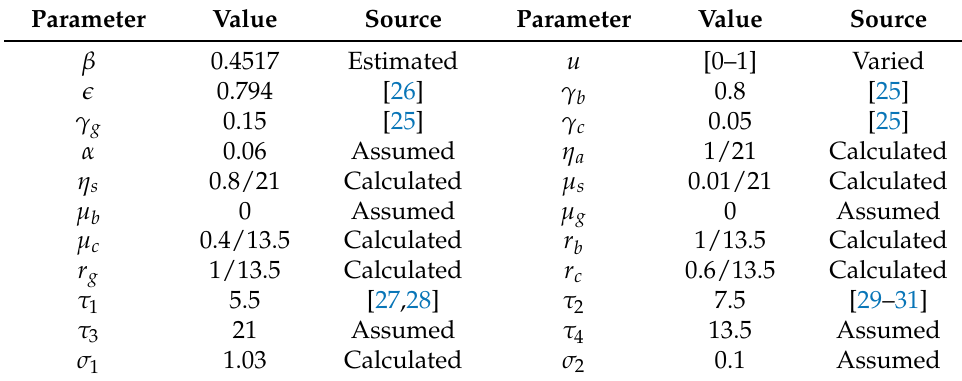
Table 1. Parameter values of models (1) and